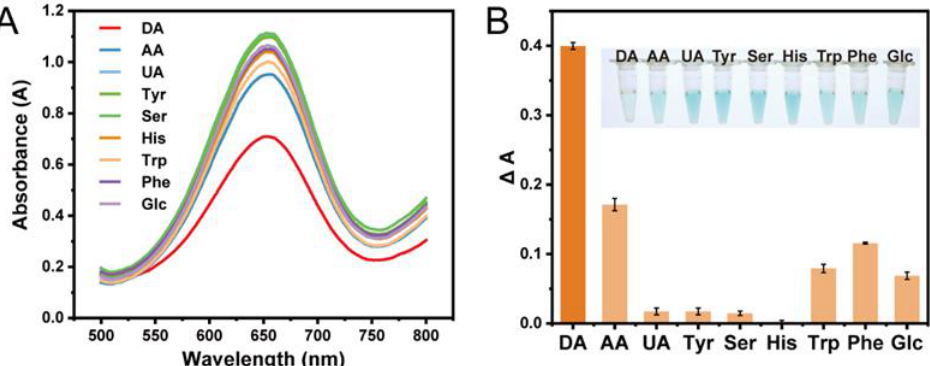
Figure 5. ( A ) UV-vis absorption curves of this colorimetric sensor for 50 μM DA and 10-fold concentration interfering compounds' detection. ( B ) The selectivity of this sensor for dopamine detection. Inset: the corresponding detection photo.